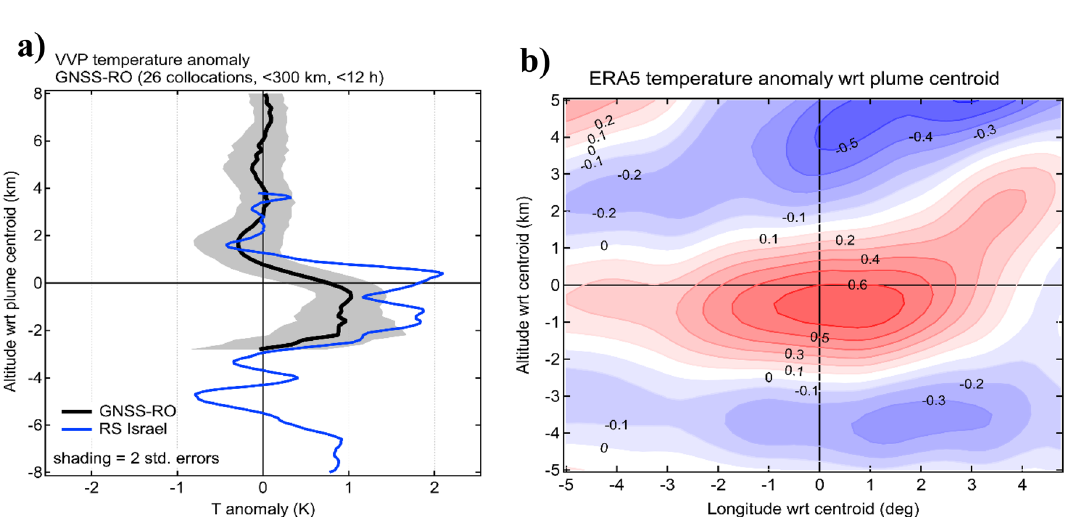
Figure 4. Circumglobal transport and diabatic lofting of the primary VVP. ( a,b ) Hovmoller diagrams of the VVP spatiotemporal evolution in zonal ( a ) and meridional ( b ) dimensions from TROPOMI (squares), CALIOP weekly averages (open circles) and OMPS-LP (filled circles with altitude color-coding). ( c,d ) Potential temperature of the VVP as a function of time ( c ) and latitude ( d ) from OMPS-LP individual detections (dots) and 3-d averages (black circles). CALIOP-derived weekly averages are shown as green open circles. Linear fit to OMPS-LP data is shown as red line in ( c ).